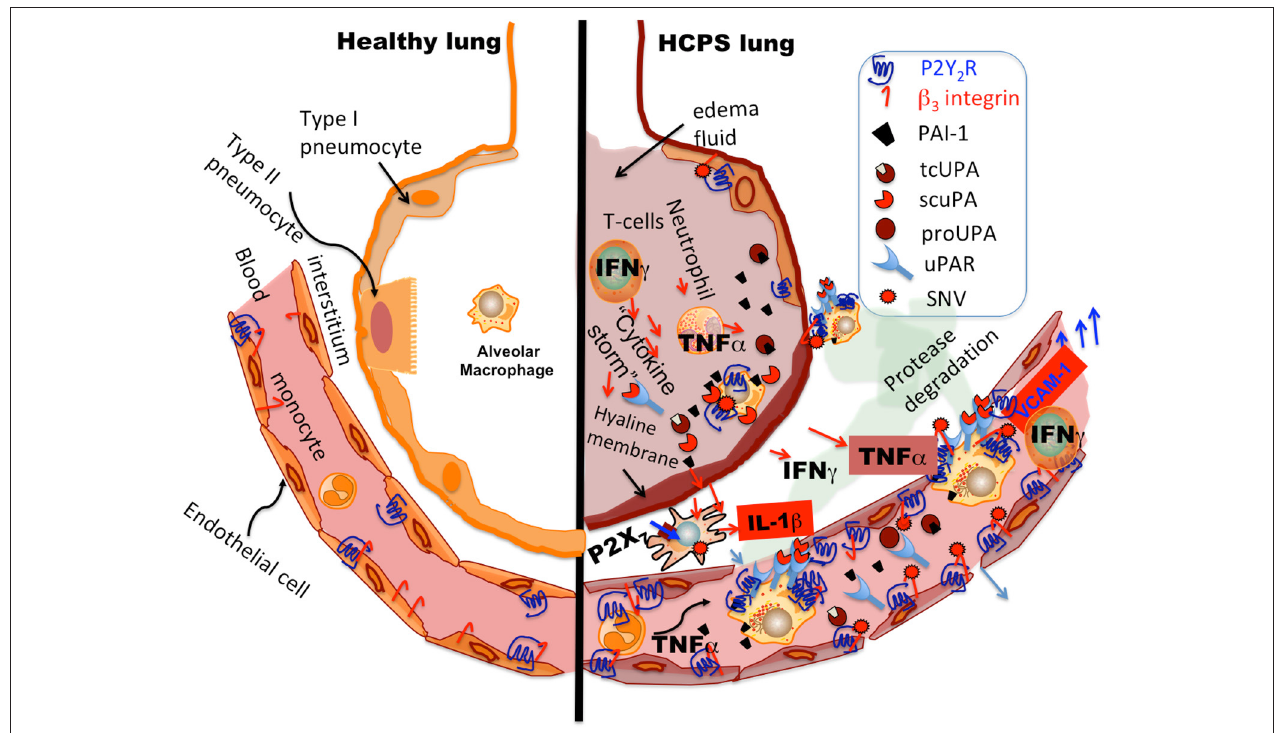
FIGURE 9 | Model of the development of P2Y 2 R, scuPA, and PAI activity during HCPS (alveolus image was adapted from Kumar et al., 2015). Macrophages and dendritic cells recognize hantavirus after inhalation. Extracellular nucleotides increase under inflammatory conditions and activate P2 receptor family subtypes, including P2X 7 and P2Y 2 R ( Hechler and Gachet, 2015). Activation of P2X 7 stimulates the release of IL-1 β and upregulates P2Y 2 R in myeloid and endothelial cells. P2Y 2 R promotes, SNV infectivity, monocyte adherence to endothelial cells through VCAM-1 and contributes to chemotaxis. TNF α primarily by myeloid lineage cells and IFN- γ released by lymphocytes during HCPS (Mori et al., 1999; Safronetz et al., 2014) have been shown to upregulate soluble uPAR and expression of membrane-bound uPAR. Thus increased expression of uPAR and uPA is expected to enhance the proteolytic activity of chemotactic cells during HCPS. PAI-1 binds poorly to scuPA-uPAR complexes and might induce appositive feedback loop for increased protease activity.